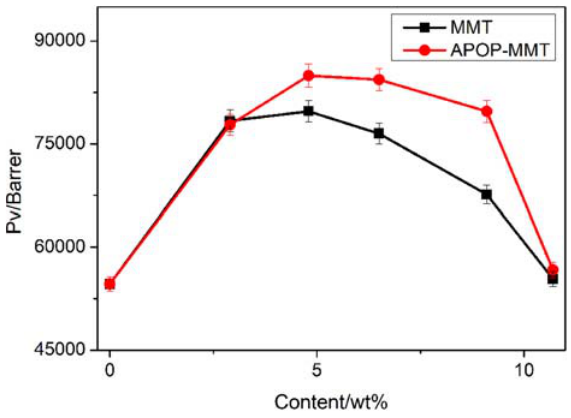
Figure 11: Vapor permeability coe ffi cient for the